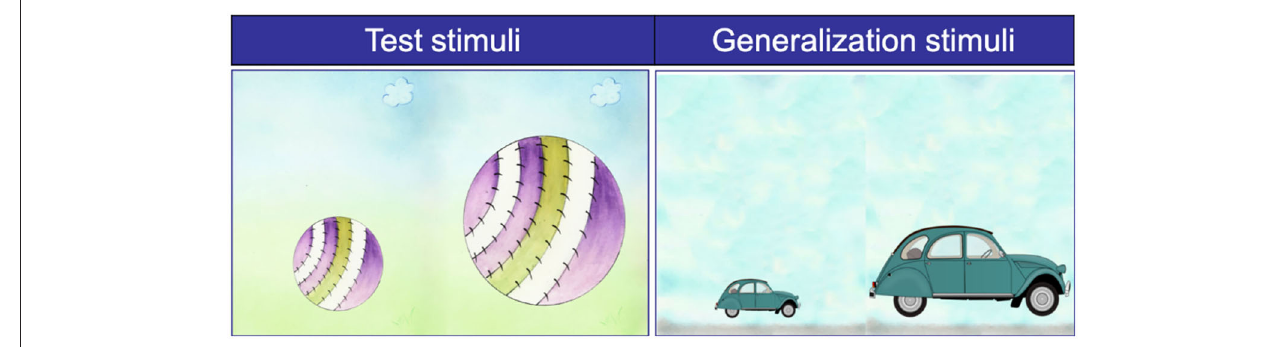
FIGURE 3 | Example stimuli used in training ( big and small ball ) and test and stimuli used in generalization questions ( big and small car ).